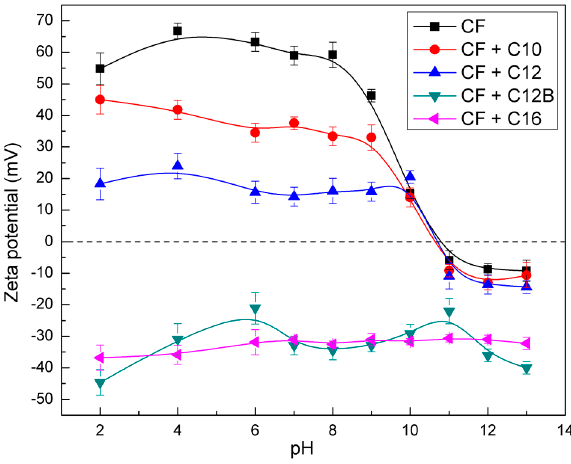
Figure 4. Zeta potentials of fluorites with and without pretreatment of sulfonate-based